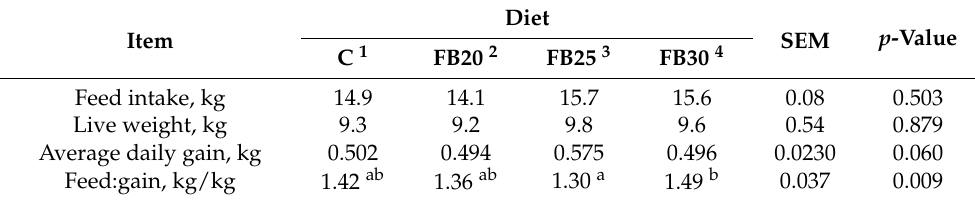
Table 2. Growth performance of pigs fed diets with extruded faba bean seeds.